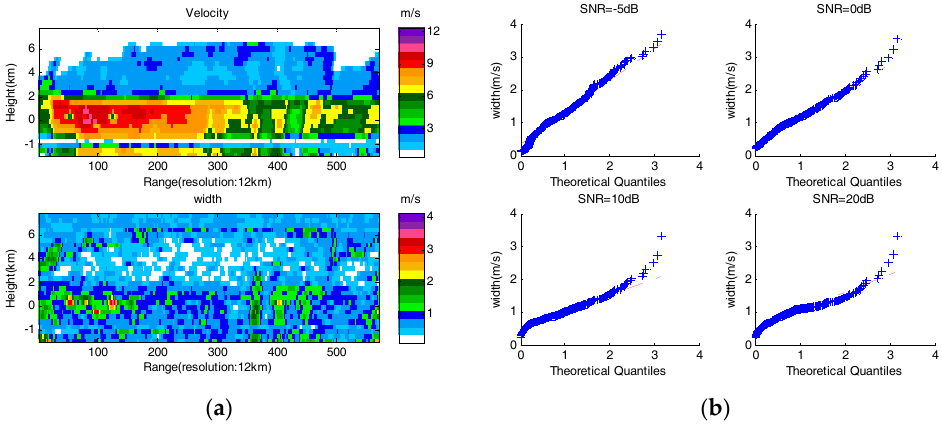
Figure 13. ( a ) Velocity and spectrum width with FDPP estimation: the maximum spectral width is 4 m/s and most of the spectral width values are within the range of 0–2 m/s. Where the marginal part and the speed value change are obvious, and the velocity data and the velocity spectrum are relatively large; ( b ) Distribution characteristics of velocity spectral width. The X -axis represents the normal distribution characteristics of the theory, and the Y -axis represents the velocity spectrum width data. The red line represents the ideal distribution; the more data scattered closer to the red line, the closer the spectral width data is to the normal